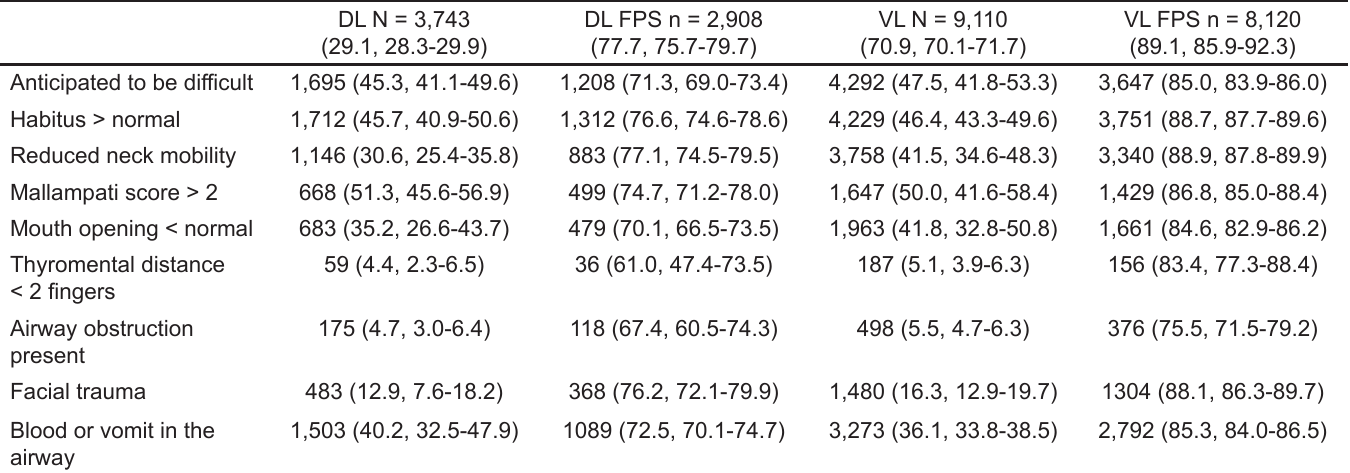
Table 2. Comparative first-pass success rates of direct laryngoscopy and video laryngoscopy for each difficult airway characteristic.